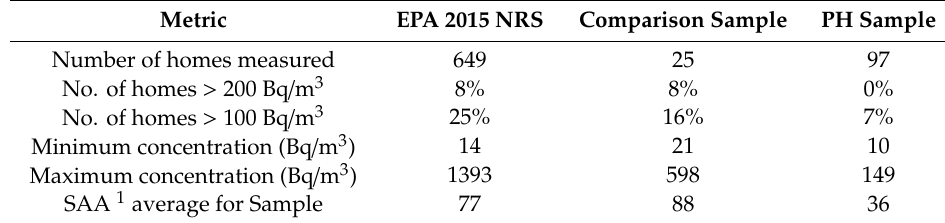
Table 1. Radon results showing the EPA 2015 National Radon Survey (NRS), the comparison sample and finally the Passive House